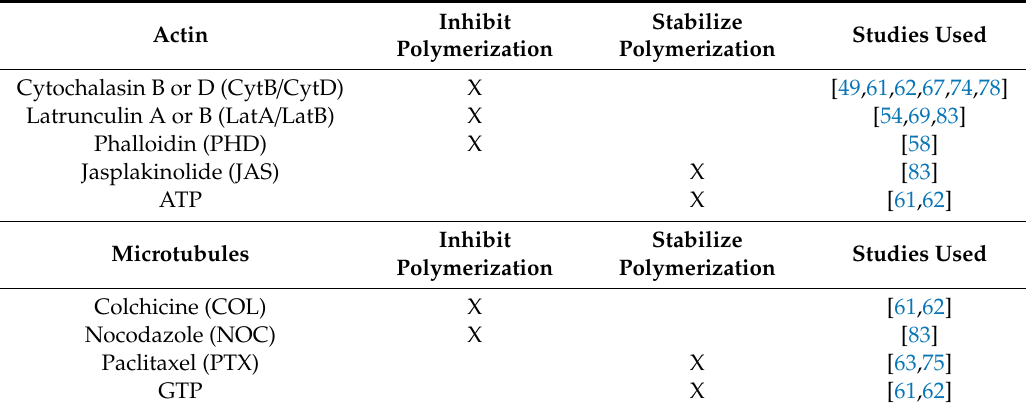
Table 2. Agents used to disrupt the